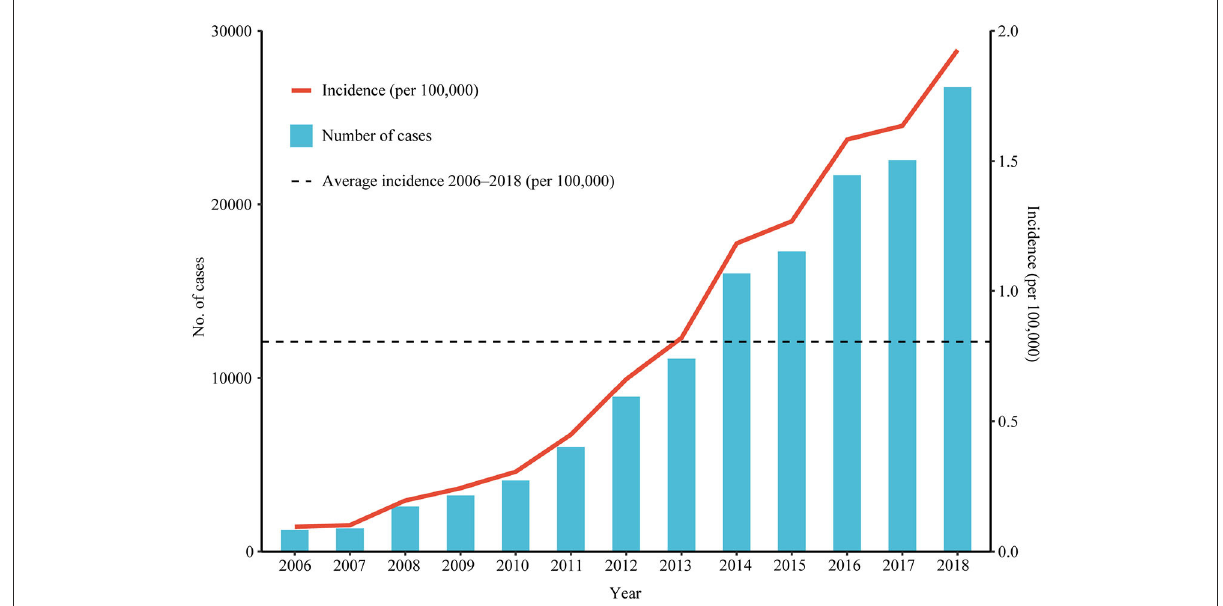
FIGURE1 The incidence and number of scrub typhus cases reported in China from 2006 to 2018. Number of cases and incidence by year.